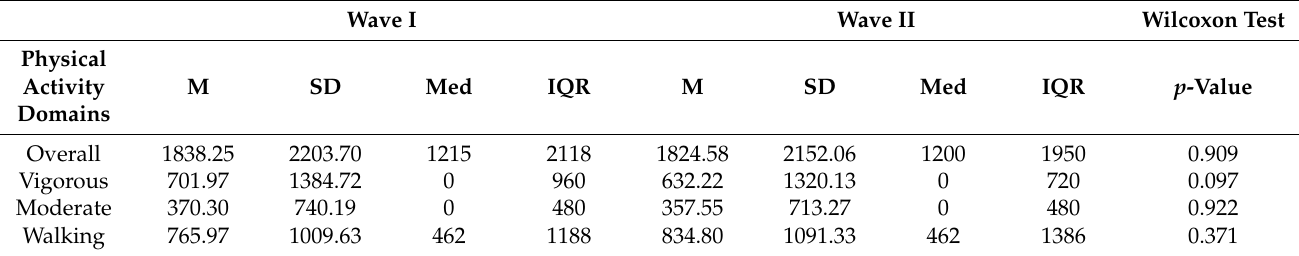
Table 2. Physical activity values (MET minutes/week) ( n = 355) in Wave I and II and Wilcoxon test for significant changes. Wave I Wave II Wilcoxon Test